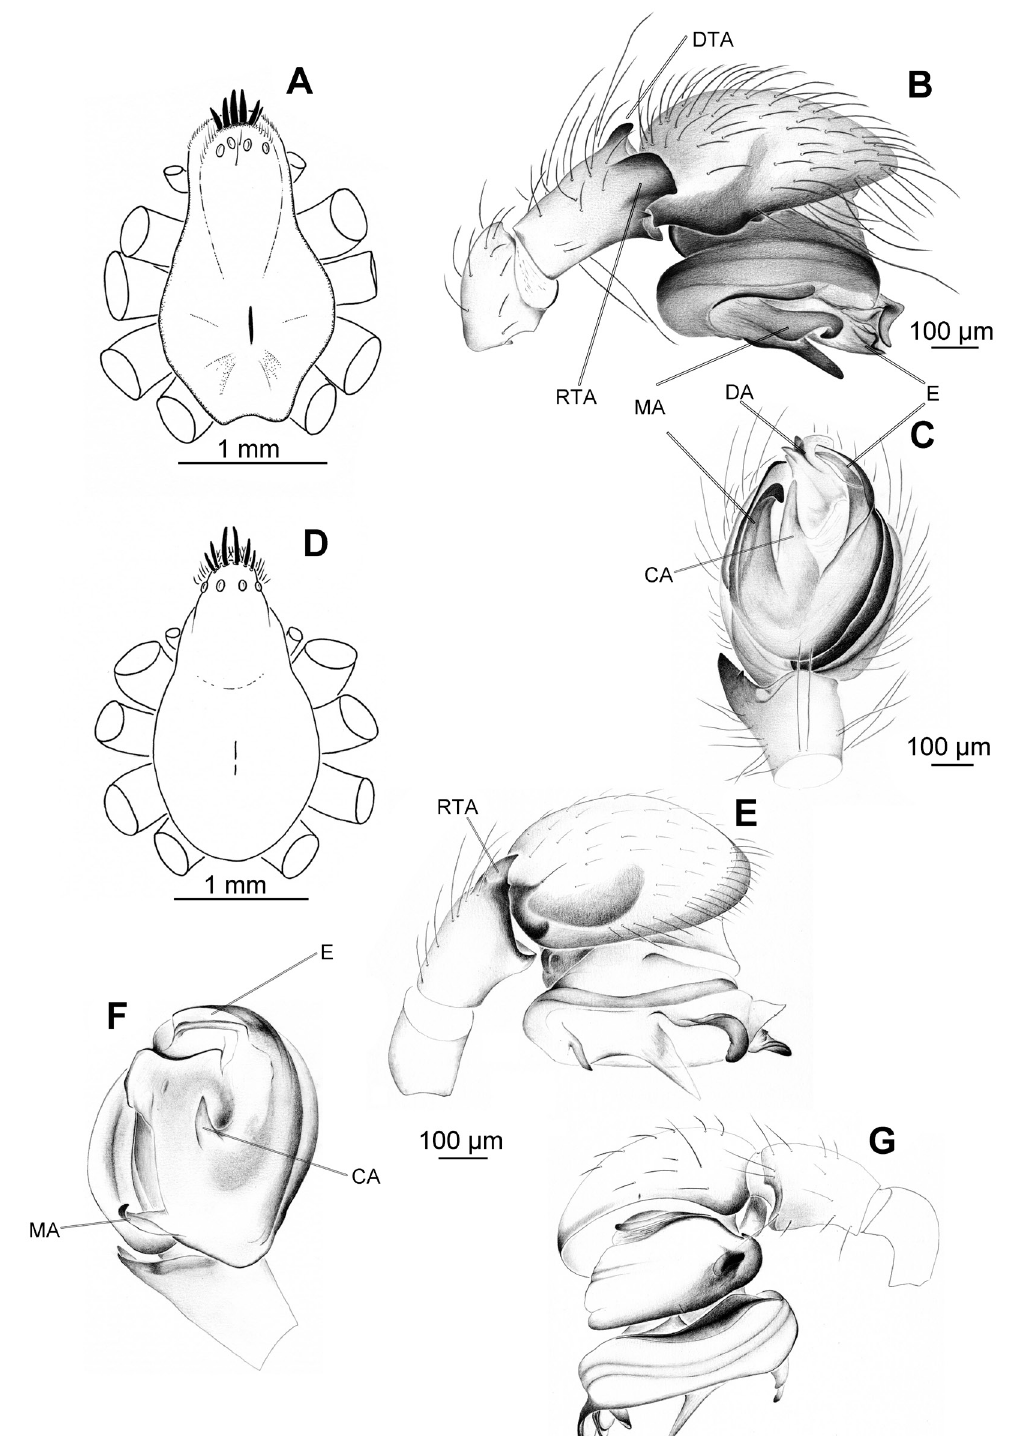
Fig. 3. – A-C . Cyrioctea sawadee sp. nov., ♂ . A . Carapace, dorsal view. B . Palp, retrolateral view. C . Idem, ventral view. – D-G . Cyrioctea lotzi sp. nov., ♂ . D . Carapace, dorsal view. E . Palp, retrolateral view. F . Idem, ventral view. G . Idem, prolateral view. CA: central tegular apophysis; DA: distal tegular apophysis; DTA: dorsal tibial apophysis; E: embolus; MA: median apophysis; RTA: retrolateral tibial